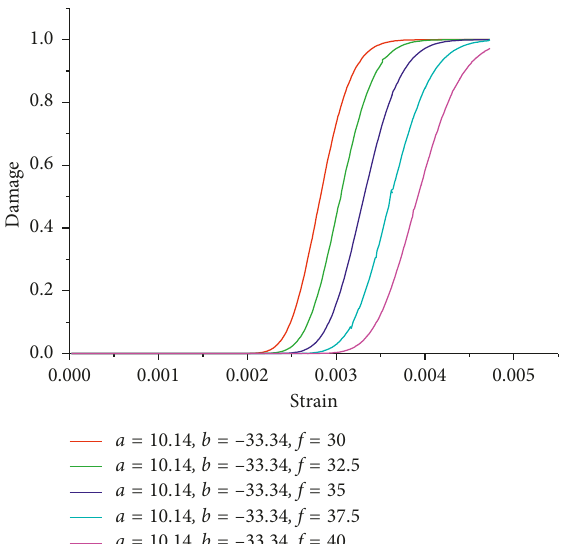
Figure 6: Impact of internal friction angle φ on damage